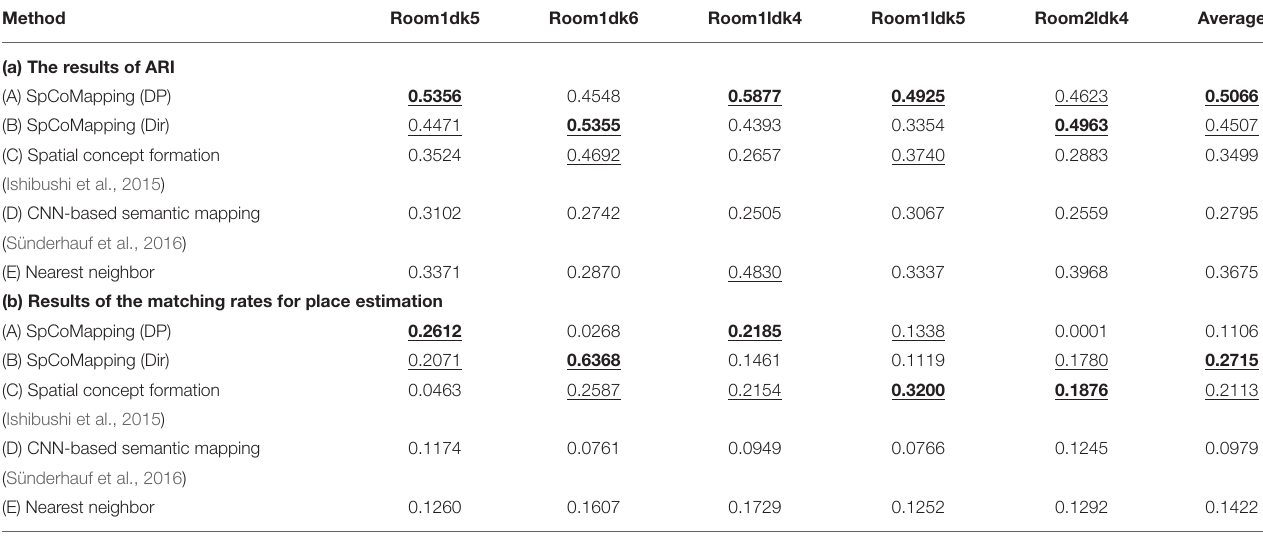
TABLE 4 | The results of simulation environment.